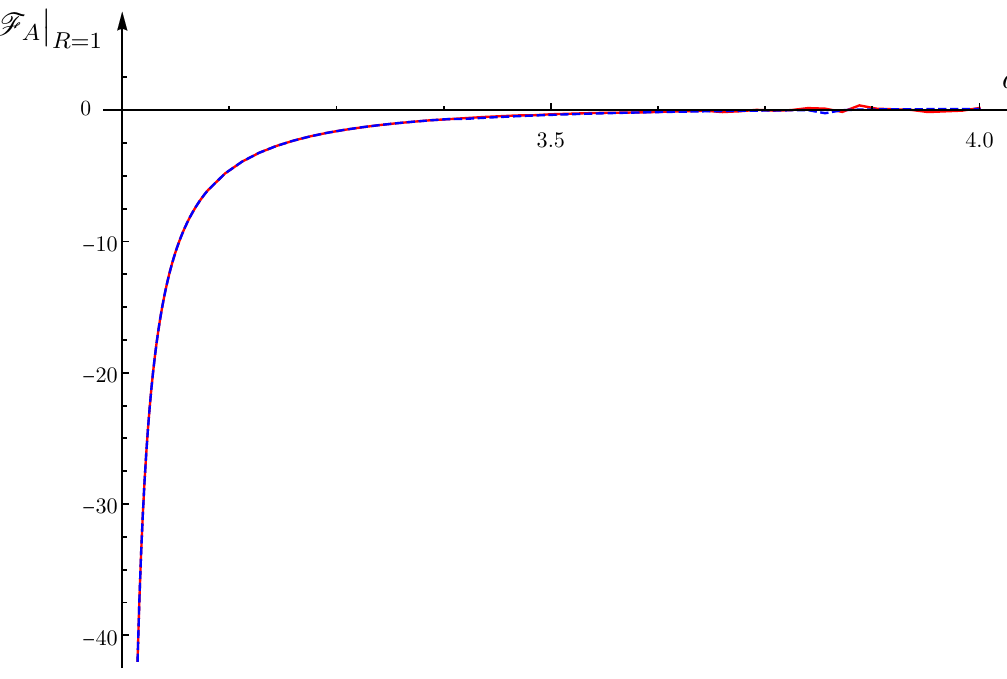
Figure 3: [come mai qui l’origine ´e messa a 5 ? sembrerebbe meglio 0 ]